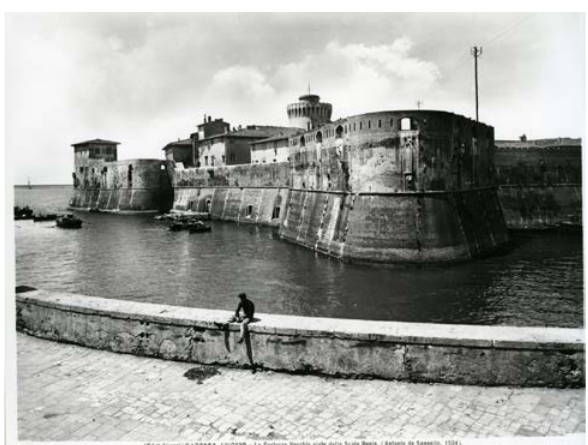
Figure 8: Archive image of the South side of Palazzo di Cosimo ( Collezione Pelosini , Courtesy Biblioteca Labronica F.D. Guerrazzi - Livorno)